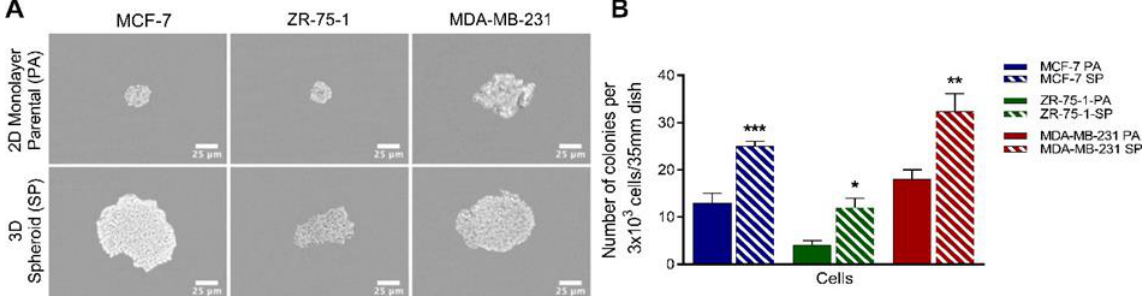
Figure 2. The colony-forming potential of breast cancer 2D monolayer cells and 3D spheroids using the methylcellulose colony formation assay. ( A ) MCF-7, ZR-75-1, and MDA-MB-231 breast cancer 2D monolayer cells and 3D spheroids were dissociated into single cells and seeded 3 × 10 3 cells in 40% methylcellulose medium supplemented with 10% FBS and 1% penicillin in culture medium on 35-mm dishes for 14 days. Colonies generated were visualized under phase microscopy (scale bar = 25 µm). ( B ) Data from the methylcellulose colony assay show the average number of colonies per 3 × 10 3 cells/35 mm dish ± SEM of three independent experiments performed in triplicates. The number of colonies formed from the SP was compared to the corresponding PA using the unpaired two-tailed t-test comparisons with 95% confidence with indicated asterisks for statistical significance. * p ≤ 0.05, ** p ≤ 0.01, *** p ≤ 0.001, and n = 3. Abbreviations: PA, 2D monolayer parental cells; SP, 3D spheroid.